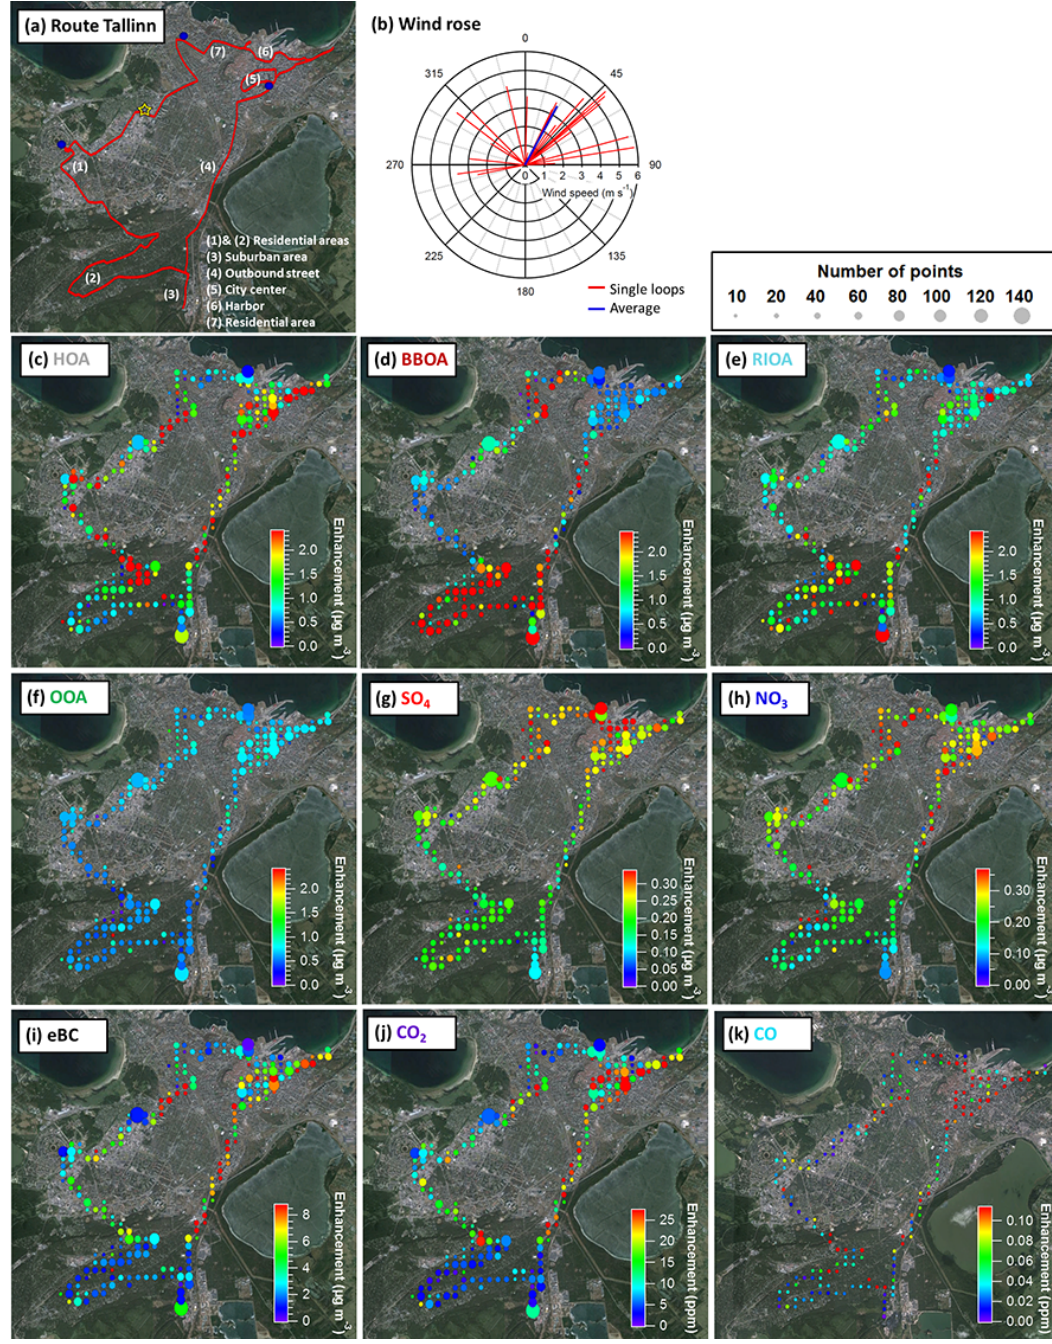
Figure 5. (a) Driving route in Tallinn: the red trace represents the GPS data, the yellow star the stationary measurements location, and the blue dots the monitoring stations of the Estonian Environmental Research Institute (EERC); (b) wind conditions during the mobile measurements in Tallinn: red traces represent the wind direction and speed for the single loops and the average of all loops is represented in blue; ( c to k ) average spatial distributions of all identified OA sources (panels c to f ) and other measured components (panels g to k ) in Tallinn. The color scales represent enhancement over the background concentrations; the maxima of the color scales have been fixed to the 75th percentile of the average enhancement of each component in panels (g) to (k) and to the highest 75th percentile among all OA sources in panels (c) to (f) . The sizes of the points represent the number of points that have been averaged in each case (note: less data available for CO).